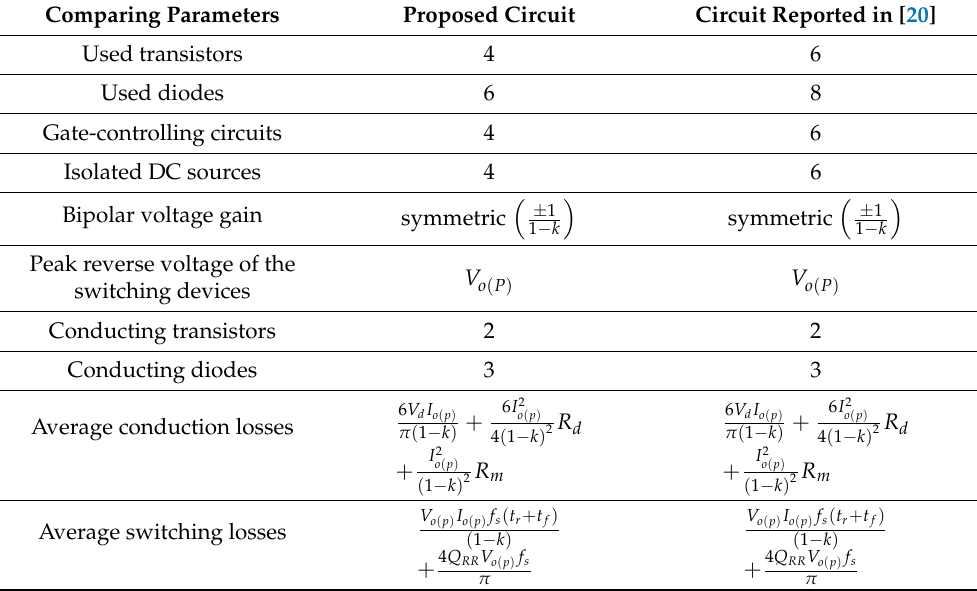
Table 1. Validation through